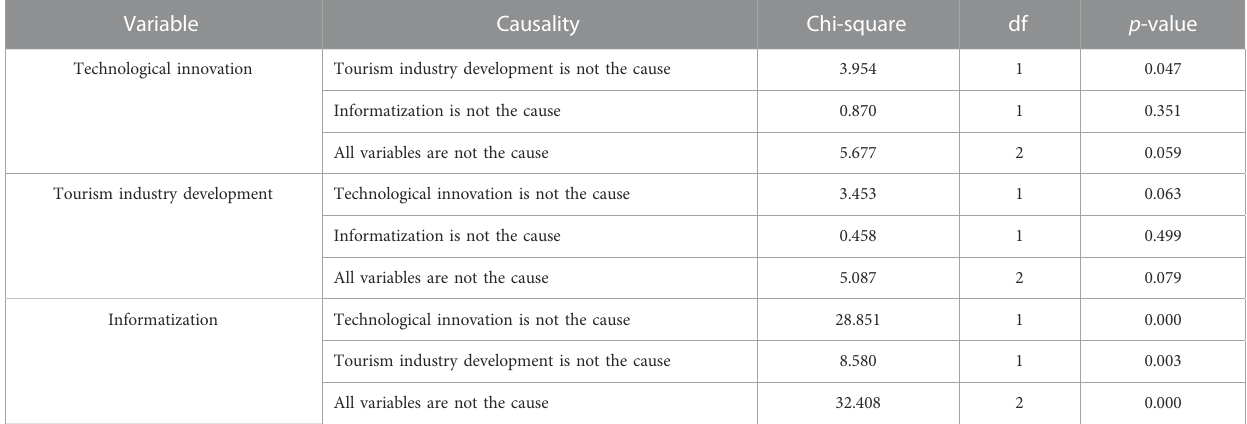
TABLE 5 Granger causality test results.